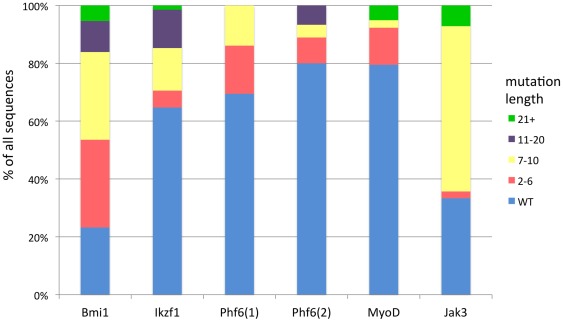
TALENs cause a wide diversity of DNA mutations.Indels were classified according to length. The frequency of different length mutations is shown as a percentage of all sequences.